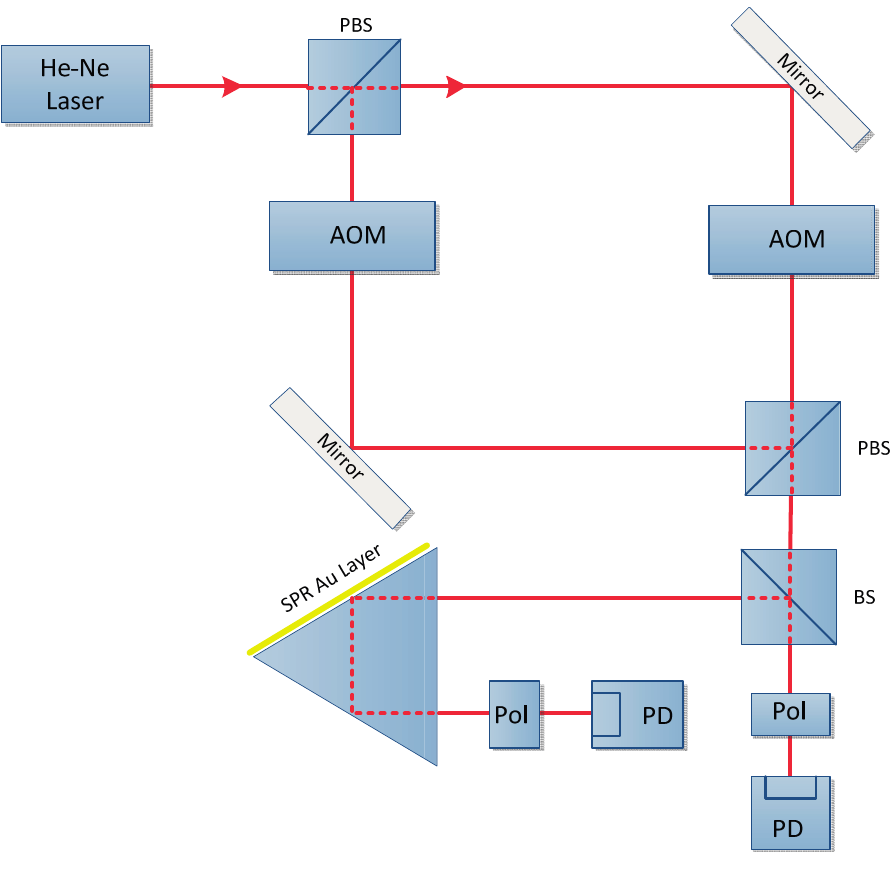
Figure 7. Schematic configuration diagram: M = mirror, PBS = polarizing beam splitter, BS = beam splitter, Pol = polarizer; AOM = Acousto-optomodulator, PhD = photo-detector (courtesy of